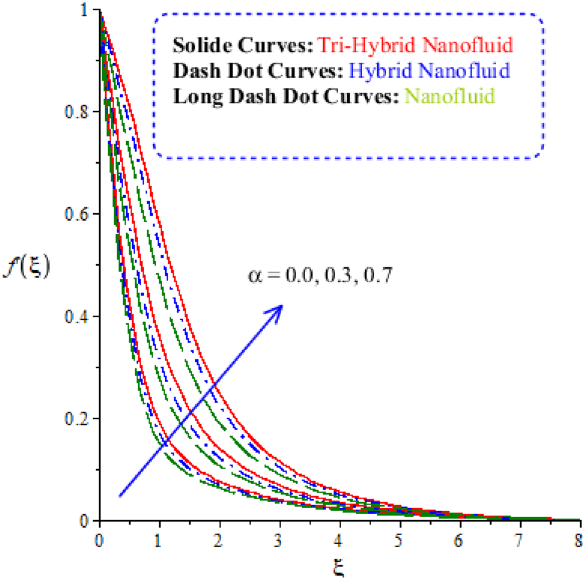
Figure 6. Comparative variation of velocity curves among nanoparticles versus α .